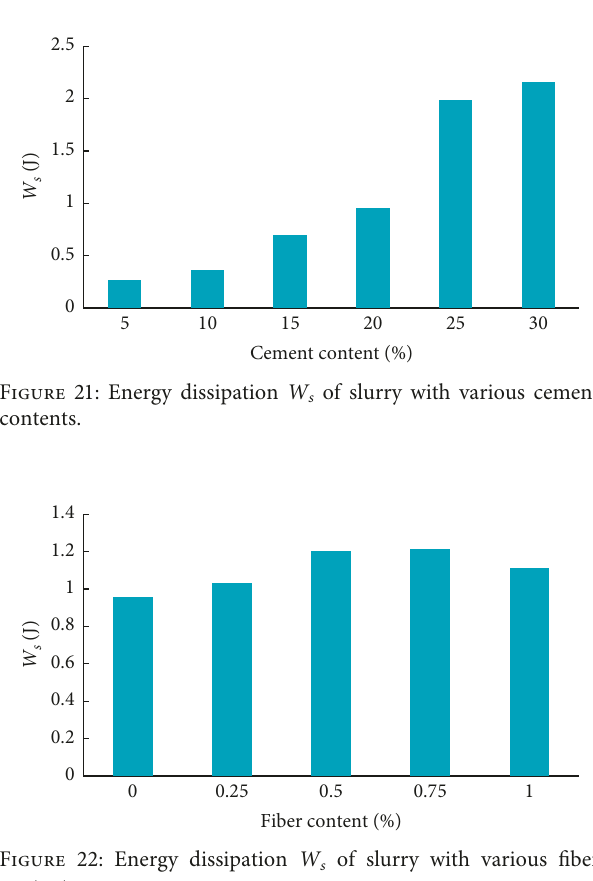
s of slurry with various fiber